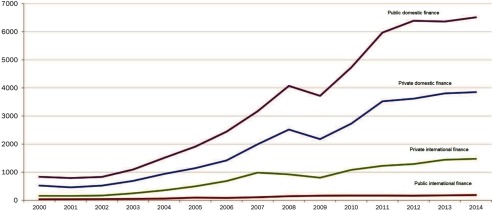
Financing Trends in Developing Countries, 2000–2014 (in US$, billions, 2013 prices)Note: Public domestic finance is defined as total government revenue. Gross-fixed capital formation by the private sector was used as an indicator for private domestic finance. Private international finance is the sum of foreign direct investment, portfolio equity and bonds, commercial banking and other lending, and personal remittances. Public international finance equals the total official flows (official development assistance and other official flows).Source: United Nations Research Institute for Social Development (2016).10